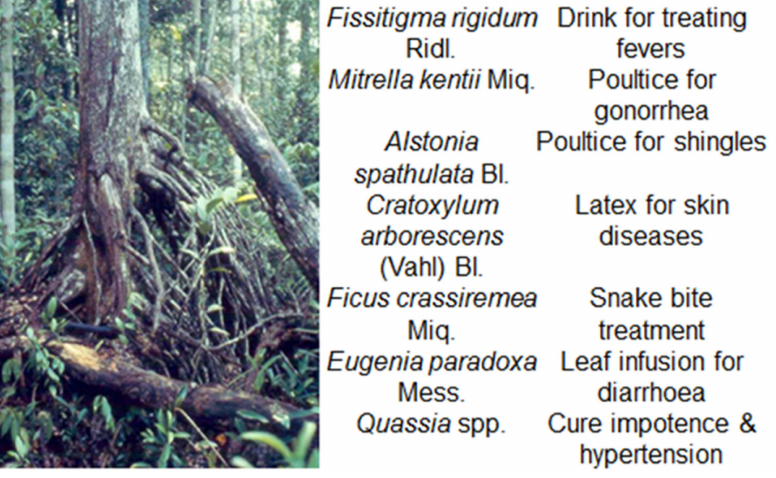
Figure 30. Wetland conversion to agriculture outside Everglades National Park—the Everglades Agricultural Area. Source: Edward Maltby. It is possible that the use of modified wetlands, such as Storm Treatment Areas (STAs), aimed to reduce the nutrient load from the Everglades Agricultural Area (Figure 30) reaching and altering the wetland ecosystems of the Everglades National Park, can be a potential solution but at costs that may prove prohibitive for application elsewhere. At smaller scales, wetlands may be used effectively as buffer zones to protect adjacent aquatic